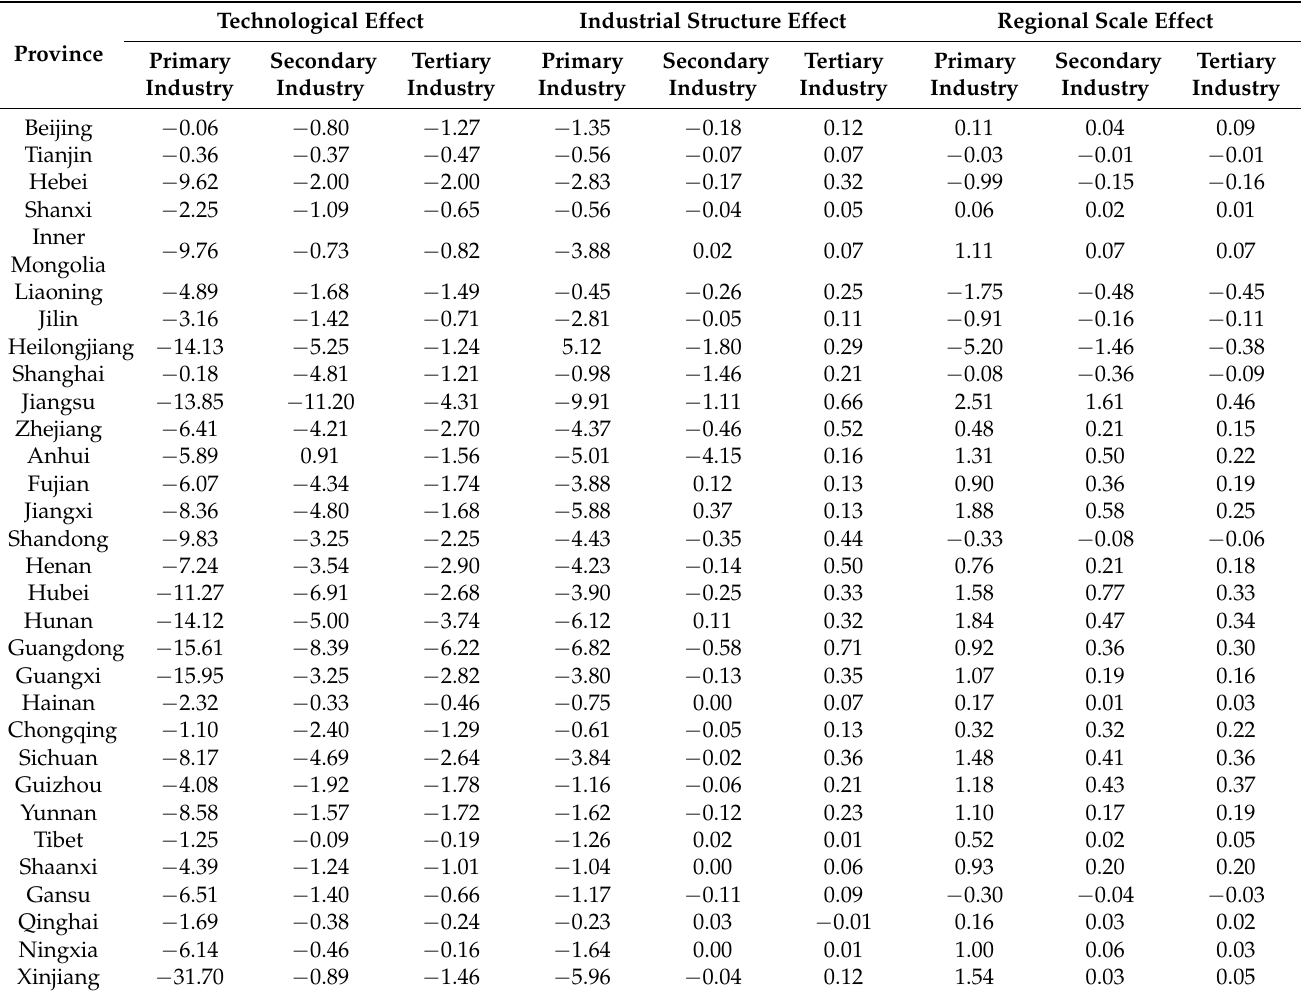
Table 3. Effects of various industries in various